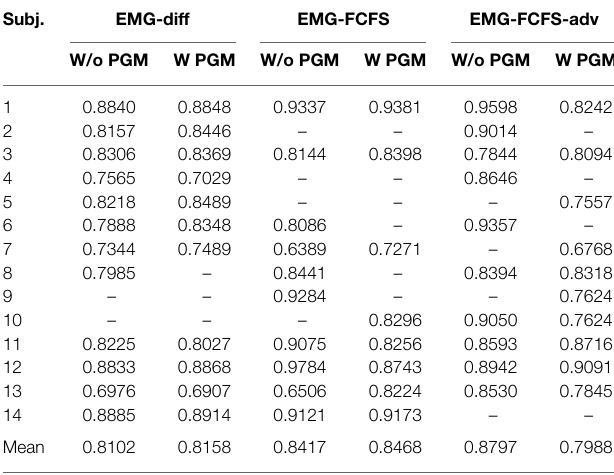
TABLE 2 | Experiment 3 : kinematic similarity index between SH-P and real user movements, for the different mapping algorithms, considering (W PGM) and discarding (W/o PGM) the proportional gain modulation . Subj. EMG-diff